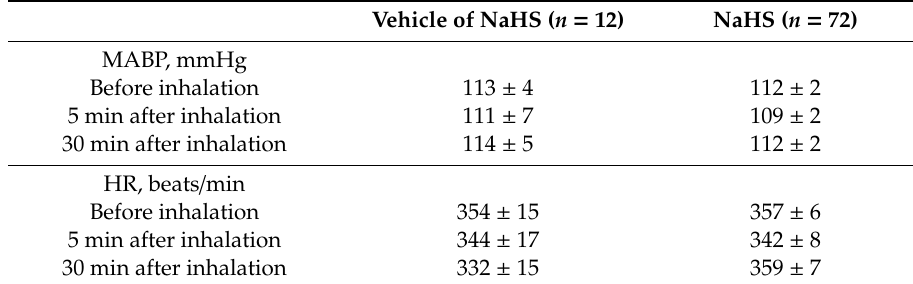
Table 1. Effects of inhalation of NaHS or its vehicle on the baseline of mean arterial blood pressure (MABP) and heart rate (HR) in anesthetized, spontaneously breathing rats. Vehicle of NaHS ( n = 12) NaHS ( n = 72) MABP, mmHg Before inhalation 113 ± 4 112 ± 2 5 min. after inhalation 111 ± 7 109 ± 2 30 min. after inhalation 114 ± 5 112 ± 2 HR, beats/min Before inhalation 354 ± 15 357 ± 6 5 min. after inhalation 344 ± 17 342 ± 8 30 min. after inhalation 332 ± 15 359 ± 7